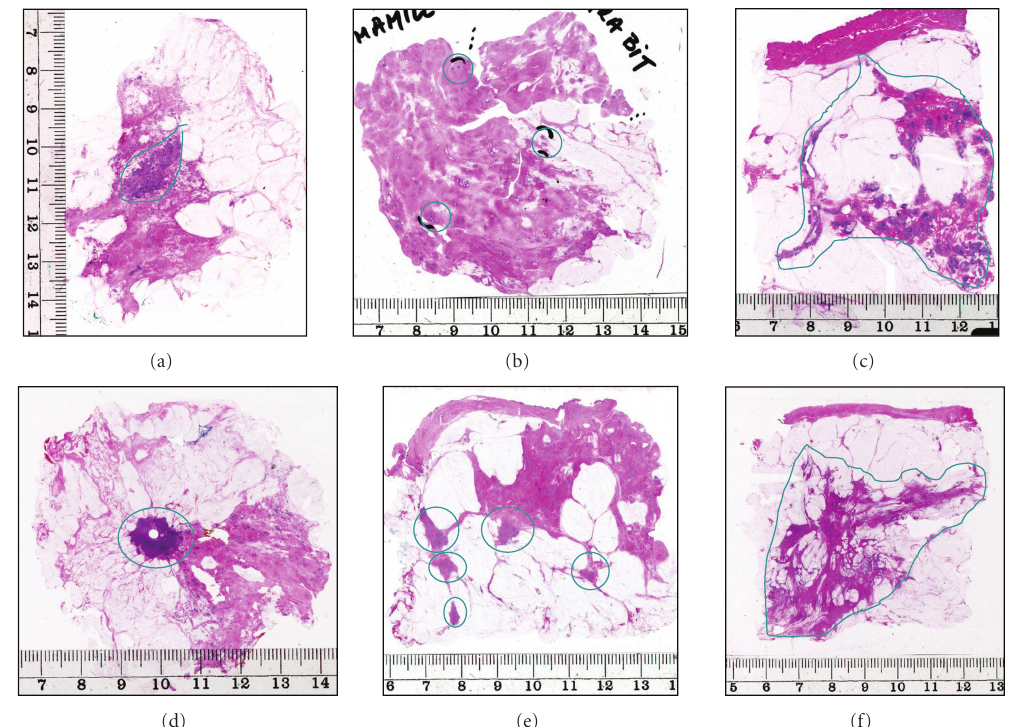
Figure 1: The basic breast cancer growth patterns. (a) Unifocal in situ carcinoma: the tumor involves neighboring terminal ductal-lobular units. (b) Multifocal in situ carcinoma: the tumor involves distant terminal ductal-lobular units. (c) Di ff use in situ carcinoma: the tumor involves large ducts and many terminal ductal-lobular units. (d) Unifocal invasive carcinoma: a single well-delineated invasive focus. (e) Multifocal invasive carcinoma: several well-delineated invasive foci in the same specimen. (f) Di ff use invasive carcinoma: poorly delineated, spider’s web-like structure. All the malignant lesions are